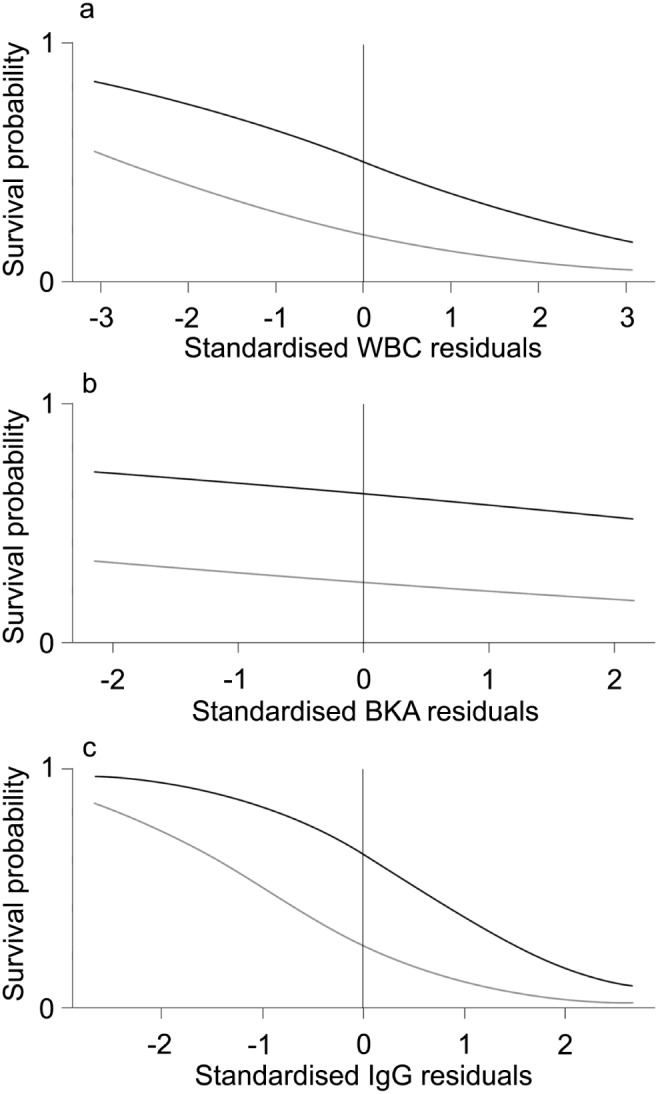
Survival probability of individuals with residual immune parameters.Standardised residuals in immune parameters depict individuals’ age-, body condition- and sex-specific deviation from average white blood cell (WBC) count, bacterial killing ability (BKA) of the plasma and immunoglobulin G (IgG) concentration. Residuals are plotted against the survival probability (males in grey, females in black). Individuals with higher WBC count (a) and higher IgG concentration (c) have lower probabilities to survive until the next season than individuals with low WBC count and low IgG concentration. BKA was not correlated with survival (b).